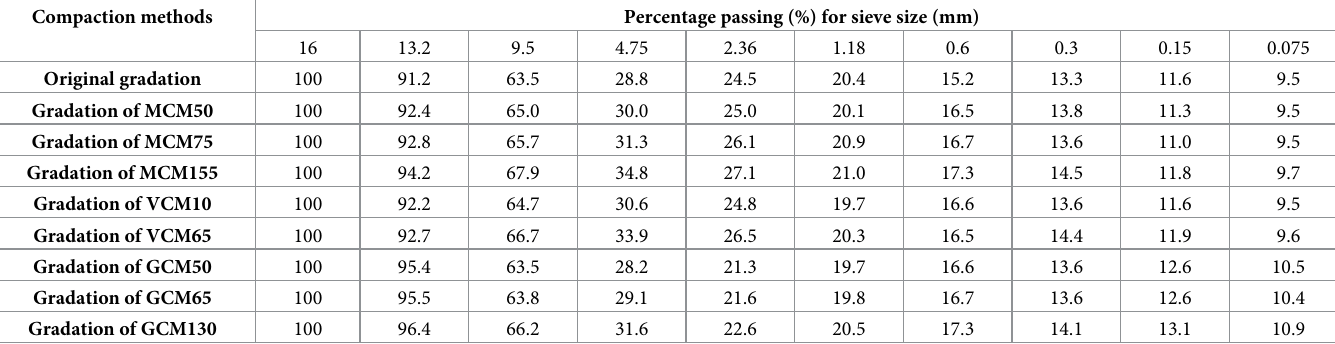
Table 11. Effect of different compaction method and compaction work on the gradation of SMA-13 mixture. Compaction